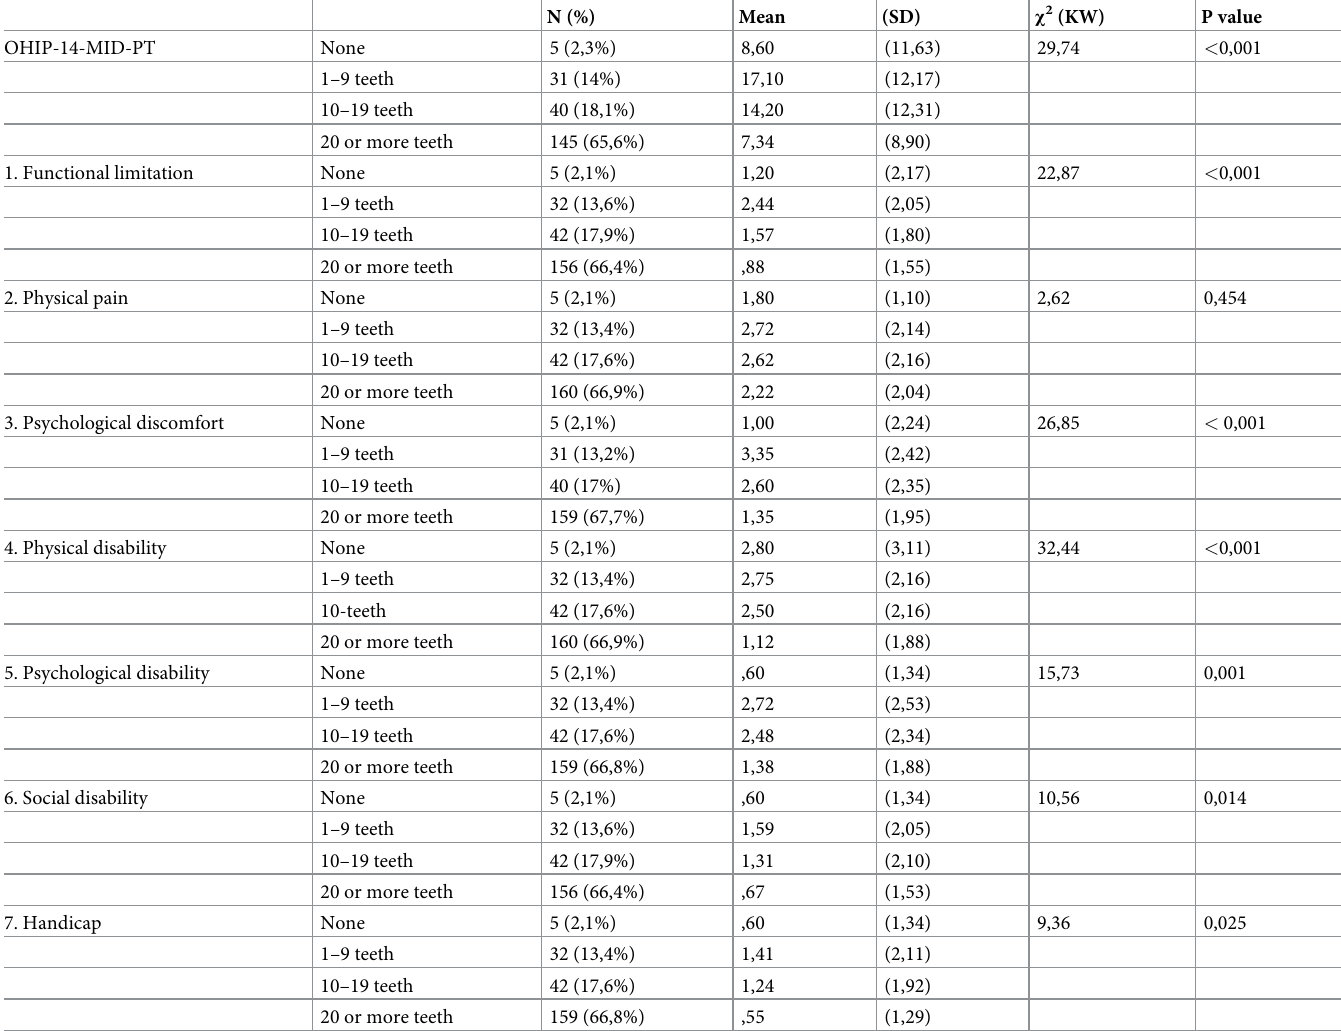
Table 2. Portuguese language validation of